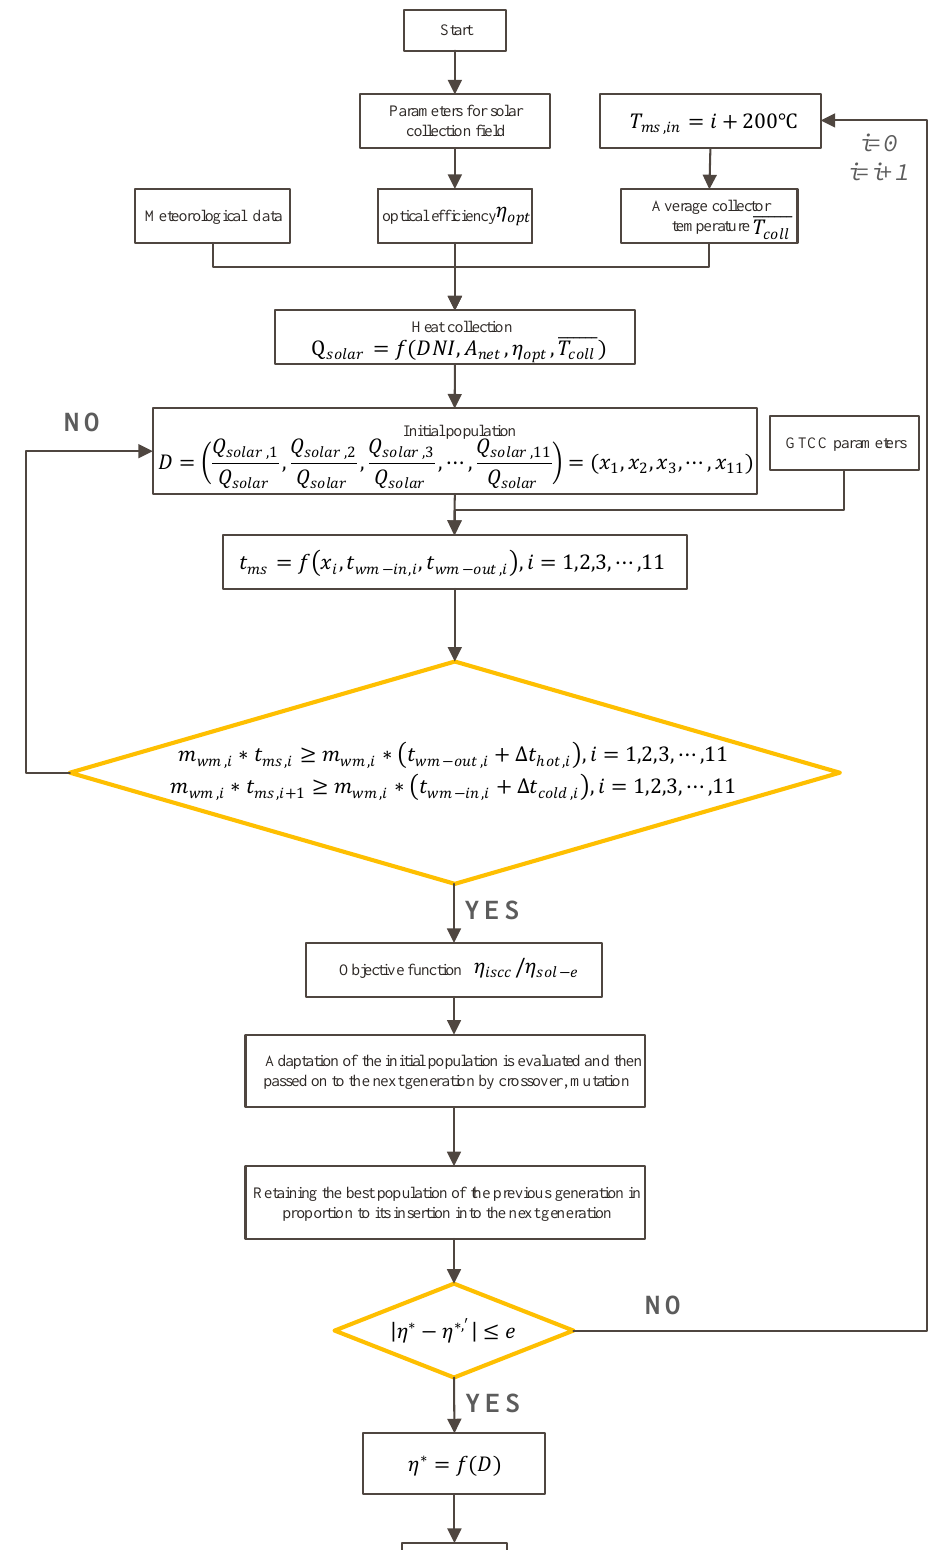
Figure 3. Optimization calculation flow chart of ISCC system.